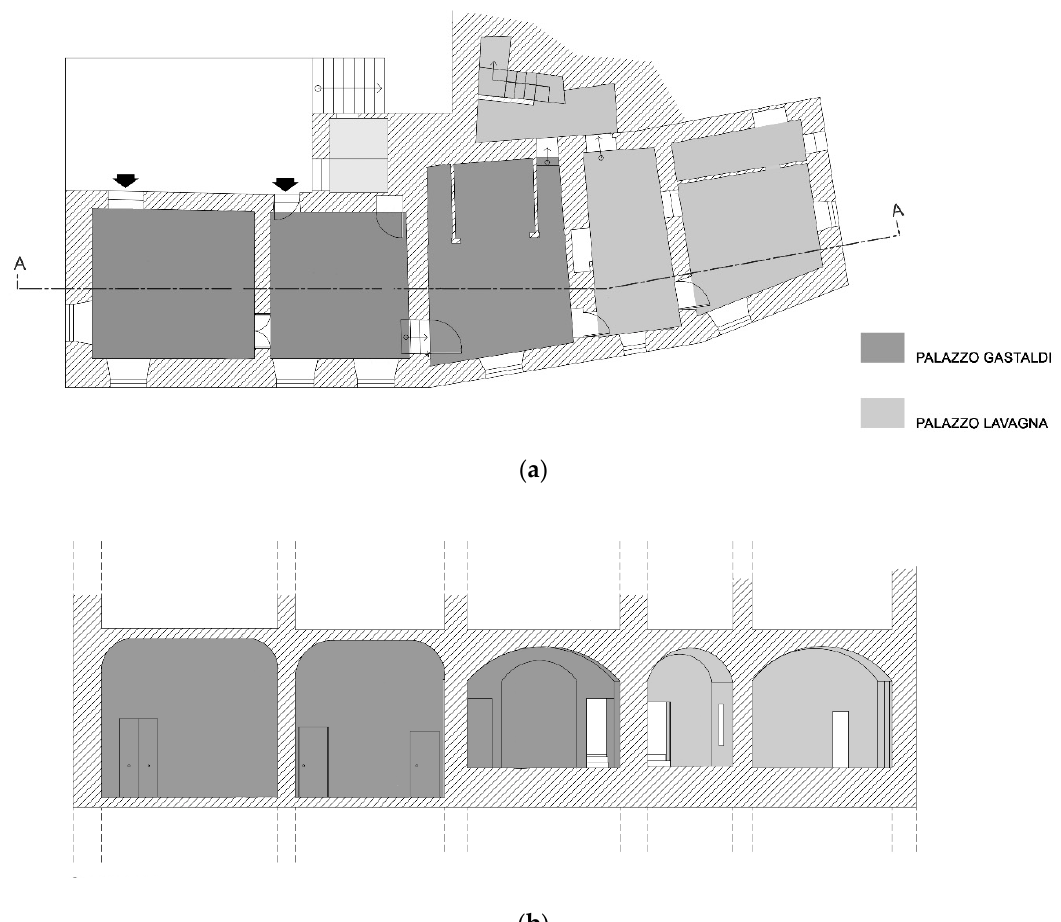
Figure 5. ( a ) Plan of the apartment and ( b ) section of the apartment.